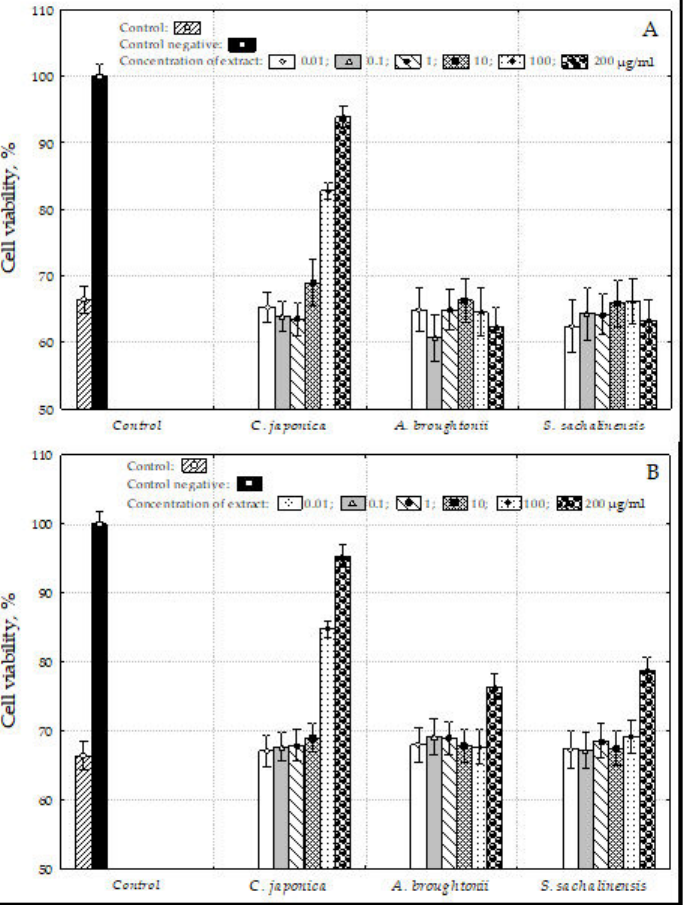
Figure 4. Effect of water bivalve extracts on cytotoxicity of t-BHP-induced HepG2 cells. ( A ) Hot water extracts; ( B ) cold water extracts; control—control sample, untreated; control negative-treated with t-BHP (0.4